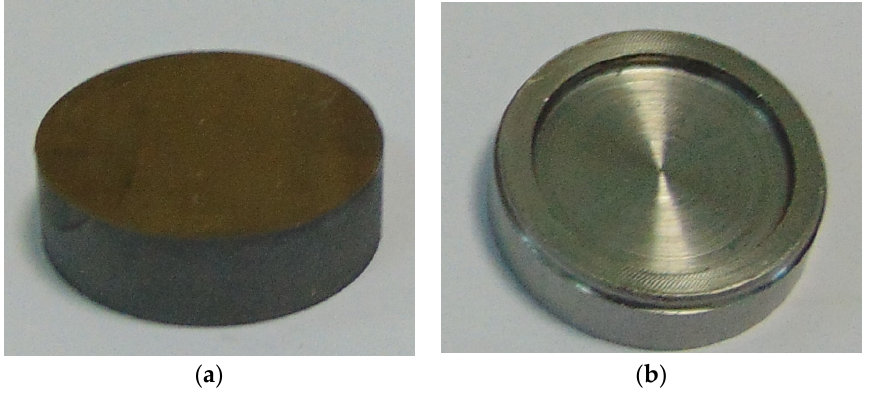
Figure 1. Untextured sample ( a ) and counter sample ( b ).